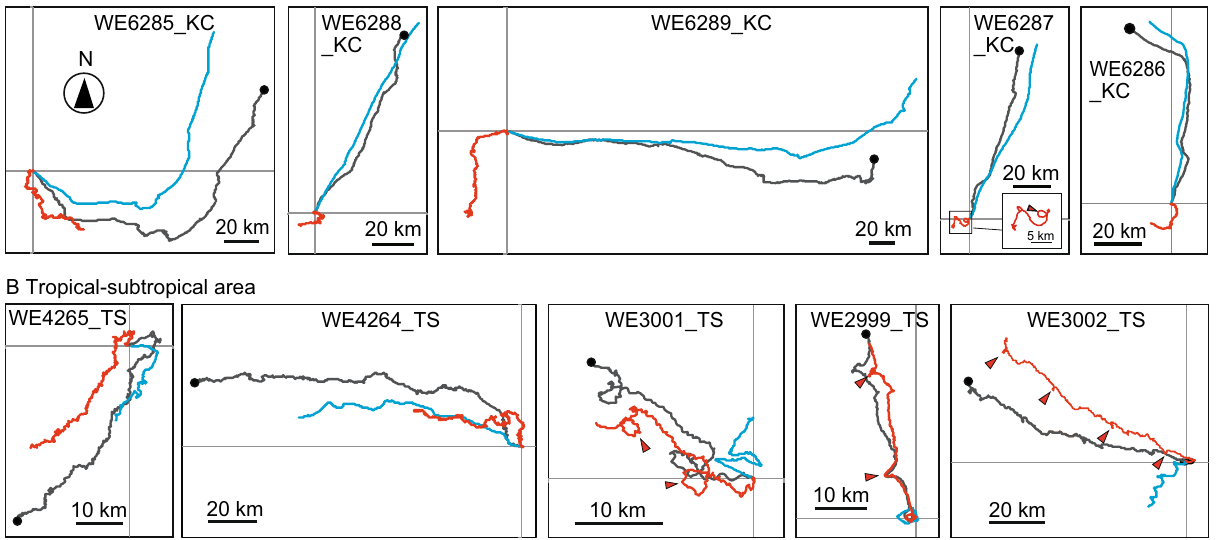
Figure 2. Trajectories during tracking eels. Travel trajectories are shown by gray lines, swimming trajectories by red lines and transport trajectories by blue lines. Vertical and horizontal lines indicate north–south axis and east–west axis with north at the top. The crossing points of two lines indicate release points. The closed circles indicate end points of tracking. Circular or bending curves around the time of solar culmination are shown by red triangles.